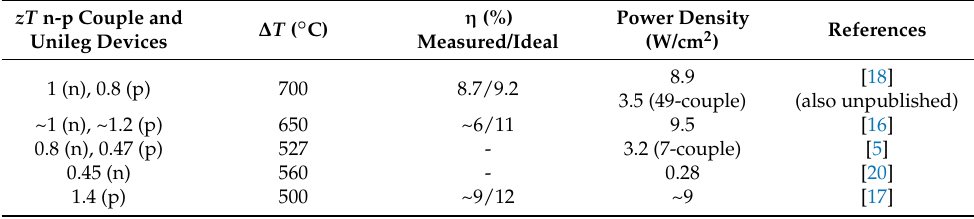
Figure 1. Thermoelectric (TE) conversion ef fi ciency for n-p couple built using Hf 0.6 Zr 0.4 NiSn 0.995 Sb 0.005 (n-type) and Hf 0.3 Zr 0.7 CoSn 0.3 Sb 0.7 /nano-ZrO 2 (p-type). Plots: measurement (cyan rhombus), calculation using temperature-averaged zT (dashed line), calculation using temperature-dependent parameters in Reference [12] (solid line). Table 2. Thermoelectric conversion efficiency and power density of n-p couple and unileg devices. zT values of the n and p legs are also included. Δ T is the temperature difference between the hot and cold ends. Data are extracted from the references. Unpublished results are noted.